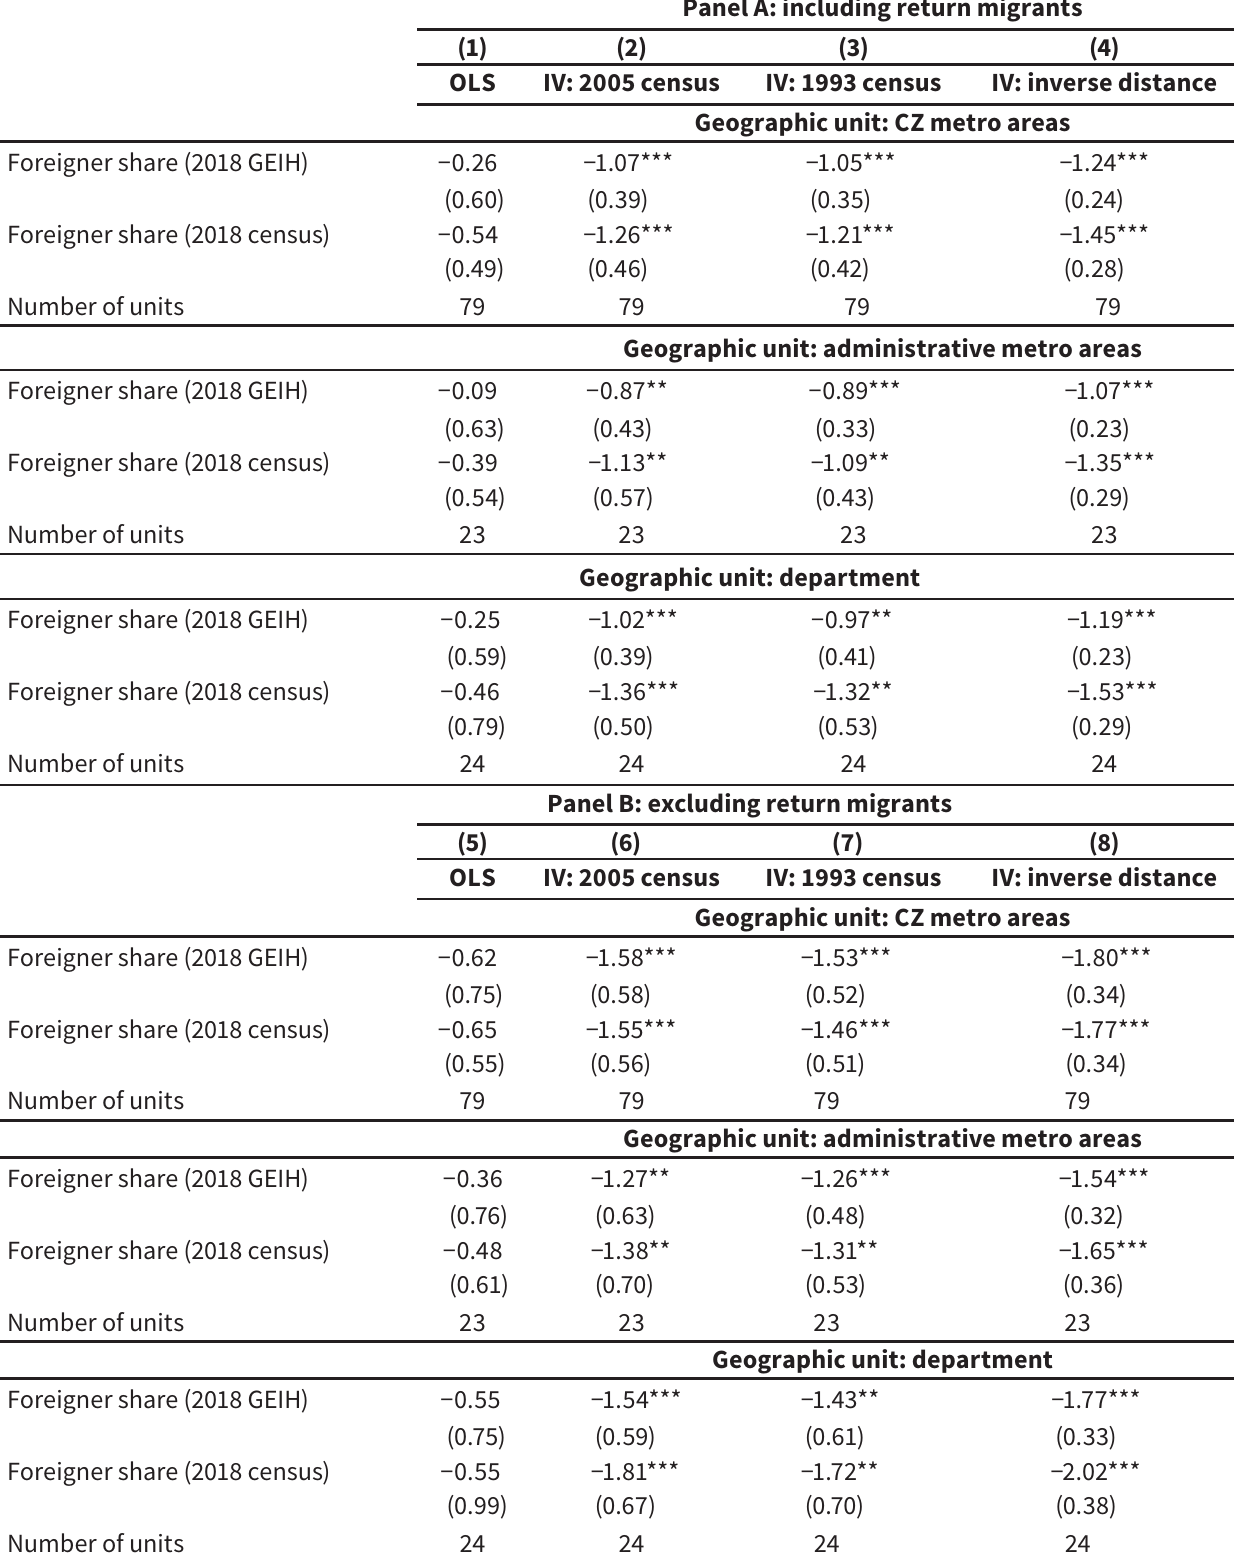
Wage estimate sensitivity: 2014–2018 difference